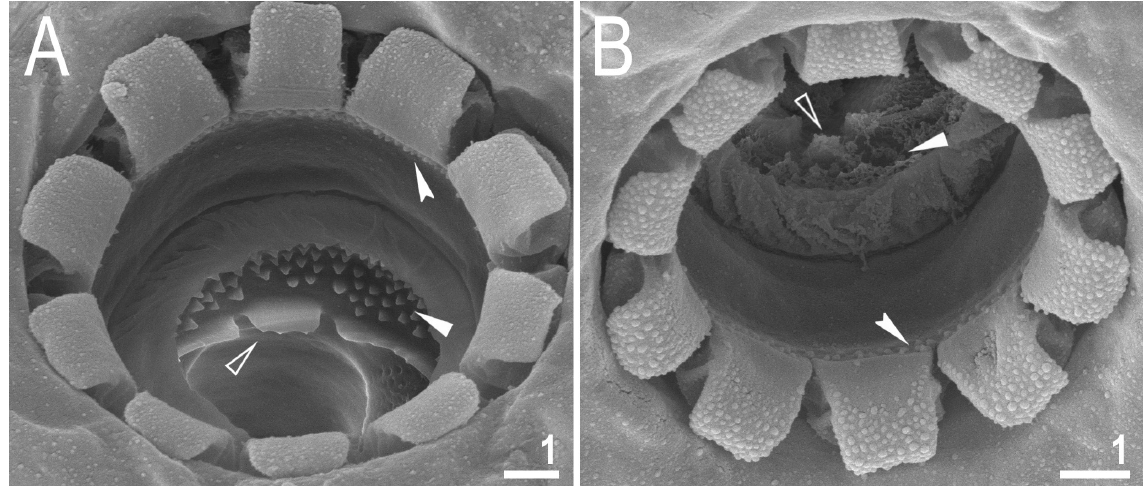
Fig. 6. Macrobiotus engbergi sp. nov. The oral cavity armature seen in SEM (paratypes). A – B . The oral cavity armature seen in SEM from different angles, dorsal (A) and ventral (B) view, respectively. Filled indented arrowheads indicate the first band of teeth in the oral cavity, filled flat arrowheads indicate the second band of teeth in the oral cavity whereas empty flat arrowheads indicate the third band of teeth in the oral cavity. Scale bars in